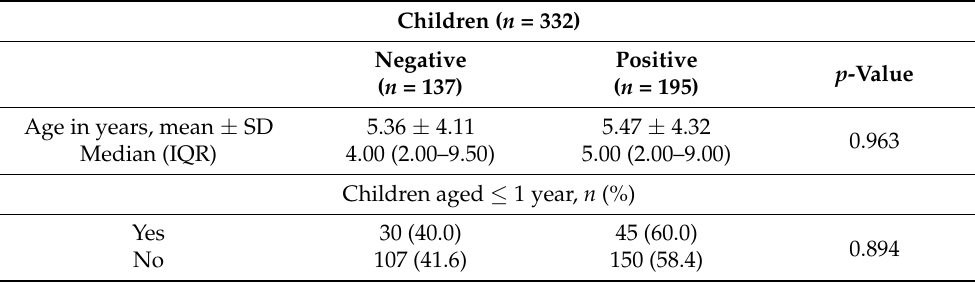
Table 2. Associations of SARS-CoV-2 serological status and characteristics of participants ( n =